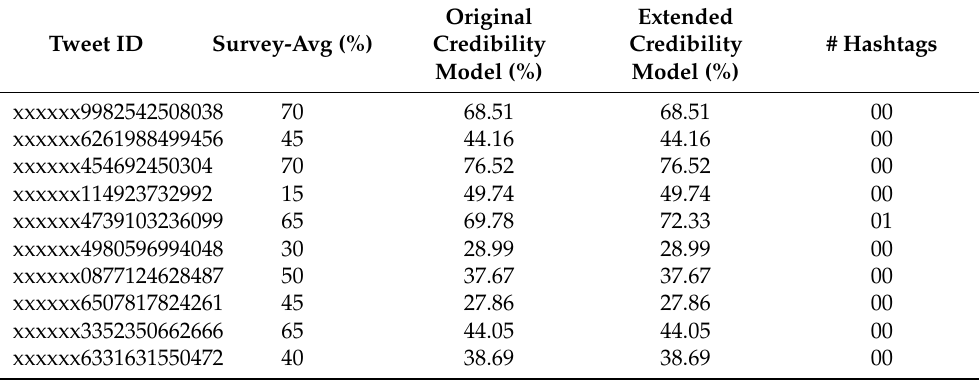
Table 6. Evaluation of the extended